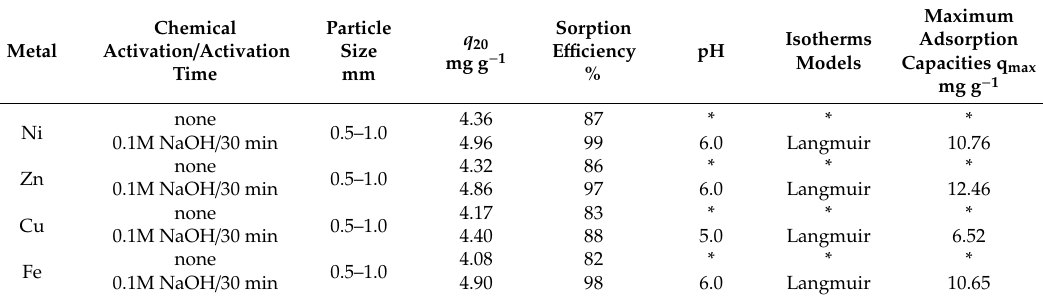
Table 3. Results obtained in laboratory tests.